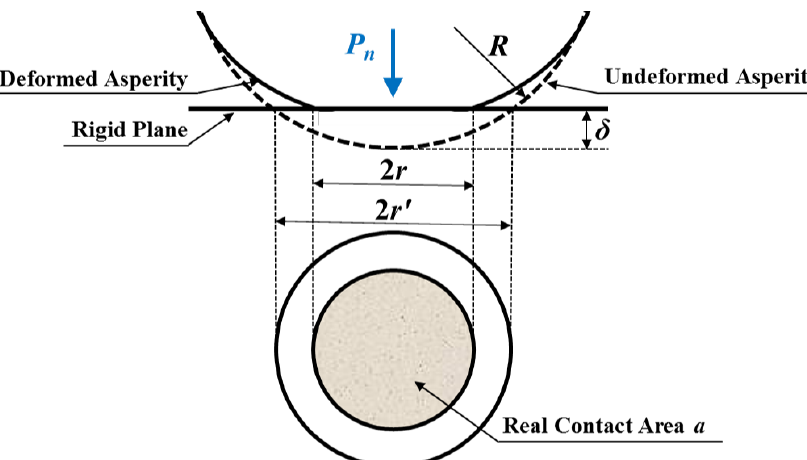
Figure 1. Contact and deformation of single asperity.